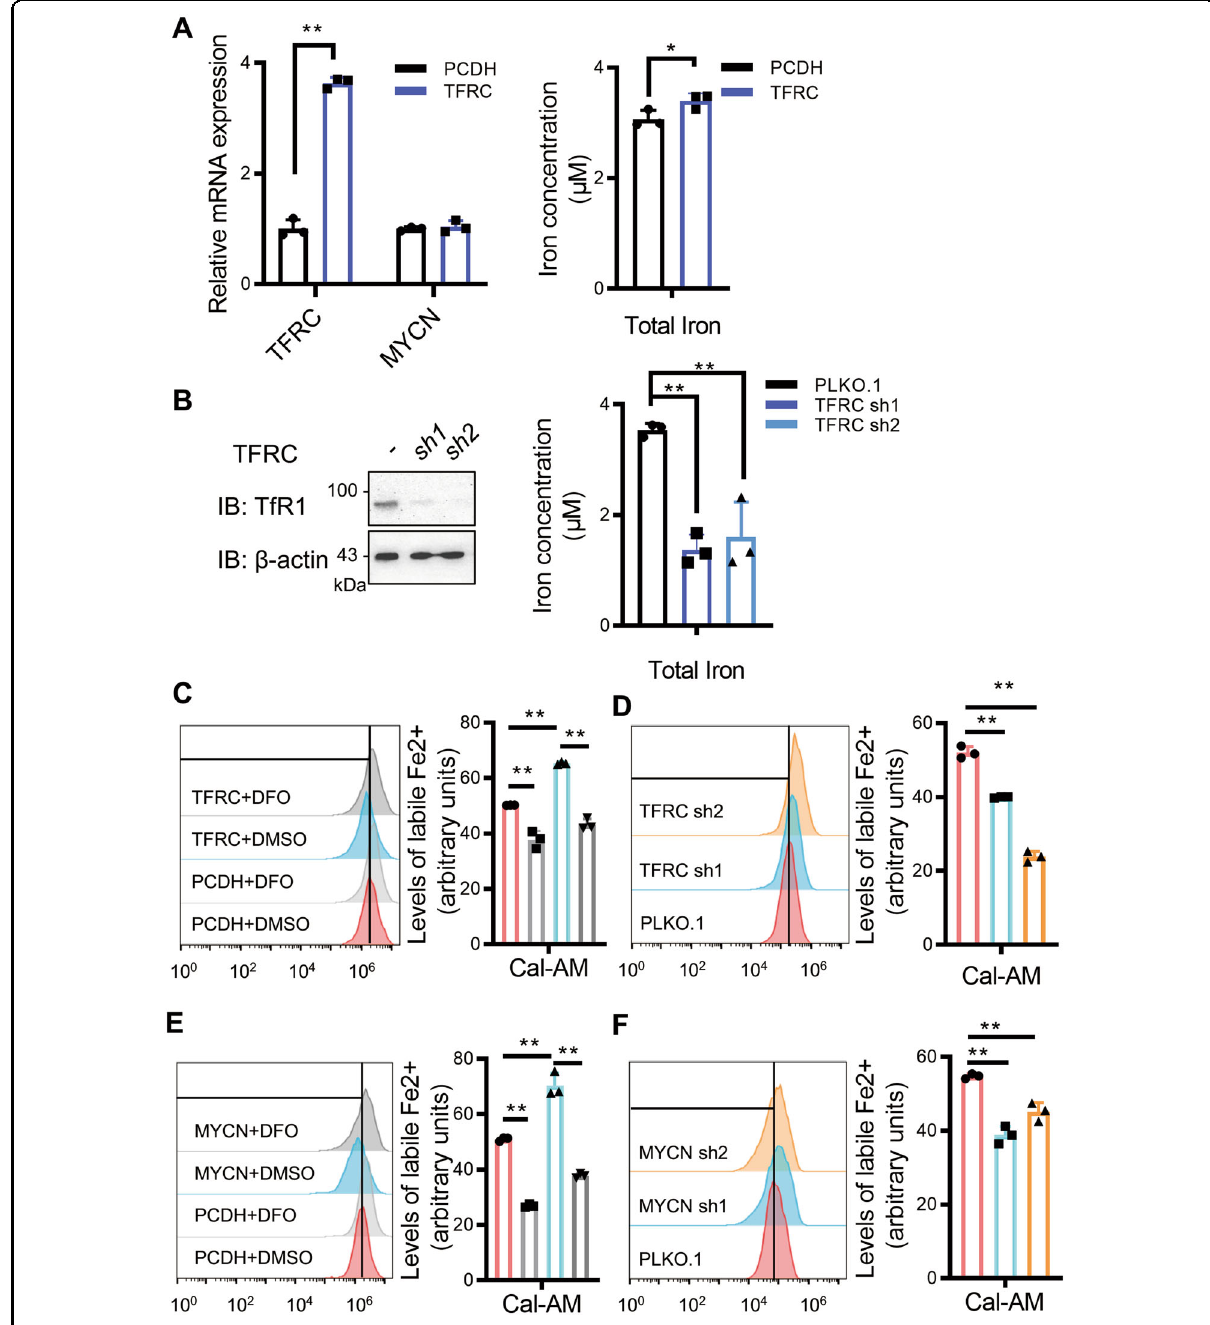
Fig. 4 TFRC photocopies MYCN to increase the labile iron pool. A Iron load and RT-qPCR analysis of SHEP cells with or without TFRC overexpression. B Iron load and western blot analysis of SK-N-BE2 cells with or without TFRC depletion. Cellular labile iron pool (LIP) was detected using the probe calcein acetoxymethyl ester (Cal-AM) in SHEP ( C ) and SK-N-BE2 ( D ) cells with or without TFRC . LIP was similarly detected in SHEP ( E ) and SK-N-BE2 ( F ) cells with or without MYCN . Data are presented as mean ± SD of three replicates. Two-tailed unpaired t -tests were performed to calculate p values. * p < 0.05, ** p <